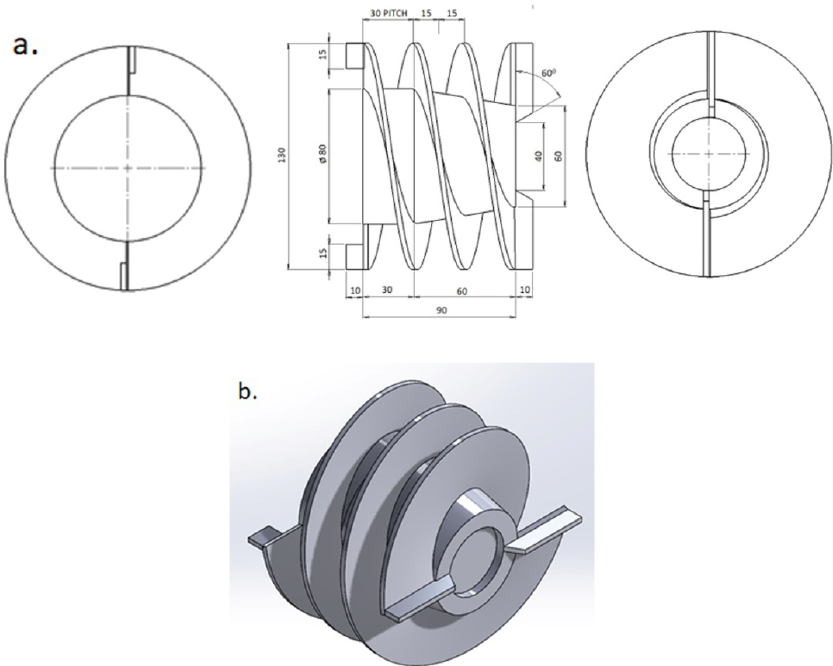
Figure 4. The twin starts helical rotor ( a ) geometric parameters ( b ) isometric view.